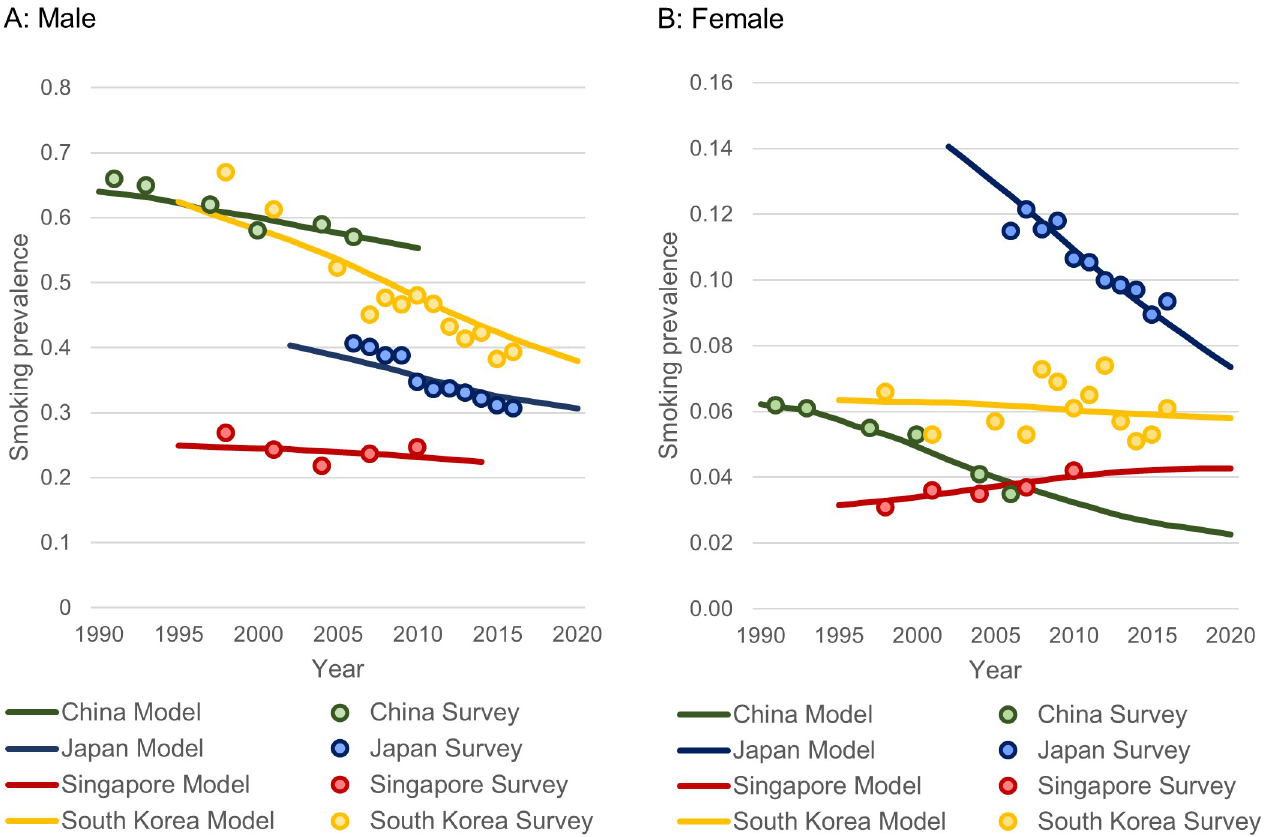
Fig 1. Smoking prevalence calibration. Model smoking prevalence (lines) calibrated to actual data from each country’s survey (dots). (A) Male. (B) Female.